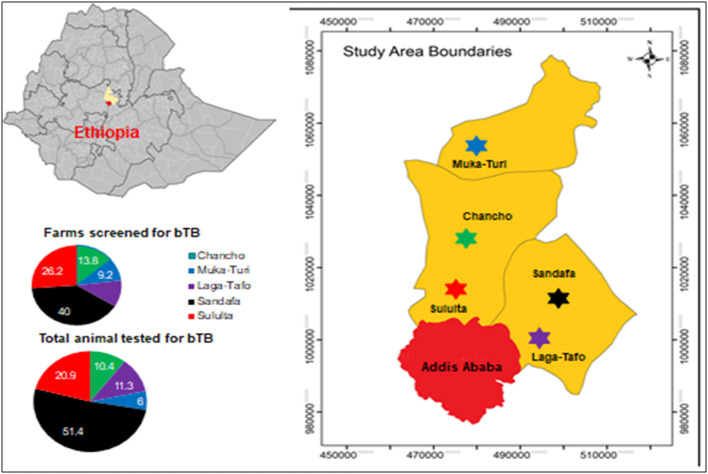
Study area. Source: https://en.wikipedia.org/wiki/Districts_of_Ethiopia.